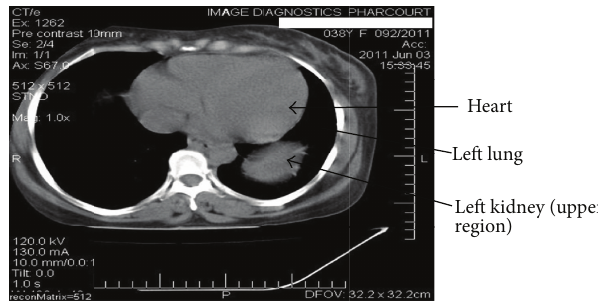
Figure 1: The left ectopic kidney found at T5/T6 transverse level.